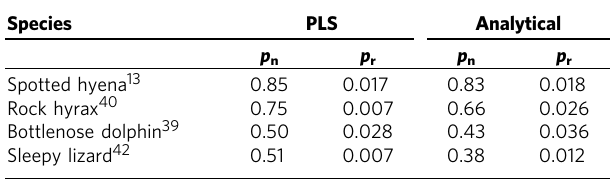
PLS, partial least squares. Predicted parameter values used in the simulations for each species (predicted by PLS regression; and predicted using analytical approximation of the mean degree and clustering coefficients). PLS values are used in Fig. 3. Supplementary Figure 7 plots the same using the estimates from the analytical approximations. A more detailed description of the PLS regression procedure and analytic approximation is in the